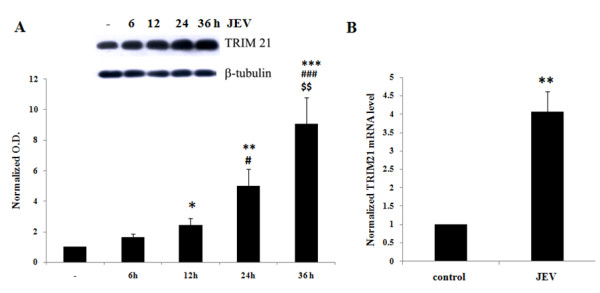
JEV induces TRIM21 protein levels in human microglial cells in a time-dependent manner. (A) CHME3 cells were either un-infected or infected with JEV at MOI 5 for 6, 12, 24 and 36 h. Cell lysates were resolved on SDS-PAGE and probed with anti-TRIM21 antibody and anti-β-tubulin antibody (loading control) by Western blotting. A representation of three independent experiments is shown along with densitometry analysis with normalization of TRIM21 against β-tubulin, averaging and plotting. (B) CHME3 cells were infected with JEV for 24 h (MOI 5). Total RNA was isolated from harvested cells. cDNA prepared by reverse transcription of control and infected samples was used as a template for qPCR against primers for TRIM21 gene. Average fold change in the TRIM21 mRNA level from three independent experiments is plotted and shown (*p < 0.05, **p < 0.01, ***p < 0.001 from control, #p from 6 h, $p from 12 h).